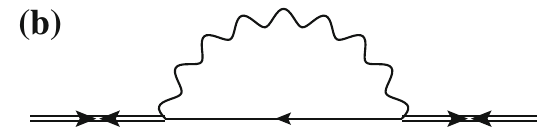
Fig. 1 One-loop self-energy diagrams for the composite neutrino. Solid lines stand for a SM lepton, either charged or neutral, and wiggled lines for the SM gauge bosons ( Z and W ± ). Solid double lines stand for